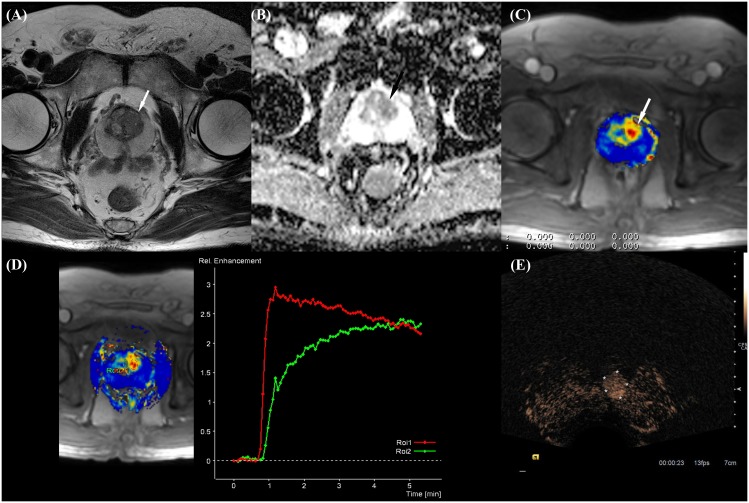
Prostate cancer in a 73-year-old man with a PSA level of 12.3 ng/mL and a history of a negative biopsy findings.A. Axial T2-weighted image in a 71-year-old man with prostate cancer in the left TZ shows homogeneous low signal intensity, ill-defined margins, and lack of a hypointense capsule (arrow). B. Corresponding ADC map shows restricted diffusion as area of low signal intensity (arrow). C. Axial perfusion map shows focal enhancement in left TZ (arrow). D. Time intensity curve shows red, type 3 enhancement curve (red circle: cancer focus). Green curve is type 1 enhancement pattern (green circle: normal tissue). E. Axial transrectal US image acquired after contrast material injection shows the corresponding an asymmetric early wash-in area on contrast pulse sequence–mode images (outlined by asterisks). Biopsy was performed targeting this area, and we were able to confirm the presence of cancer. Histopathologic examination indicated a prostate carcinoma with a Gleason score of 6 (3+3) at targeted biopsy (TB) only.